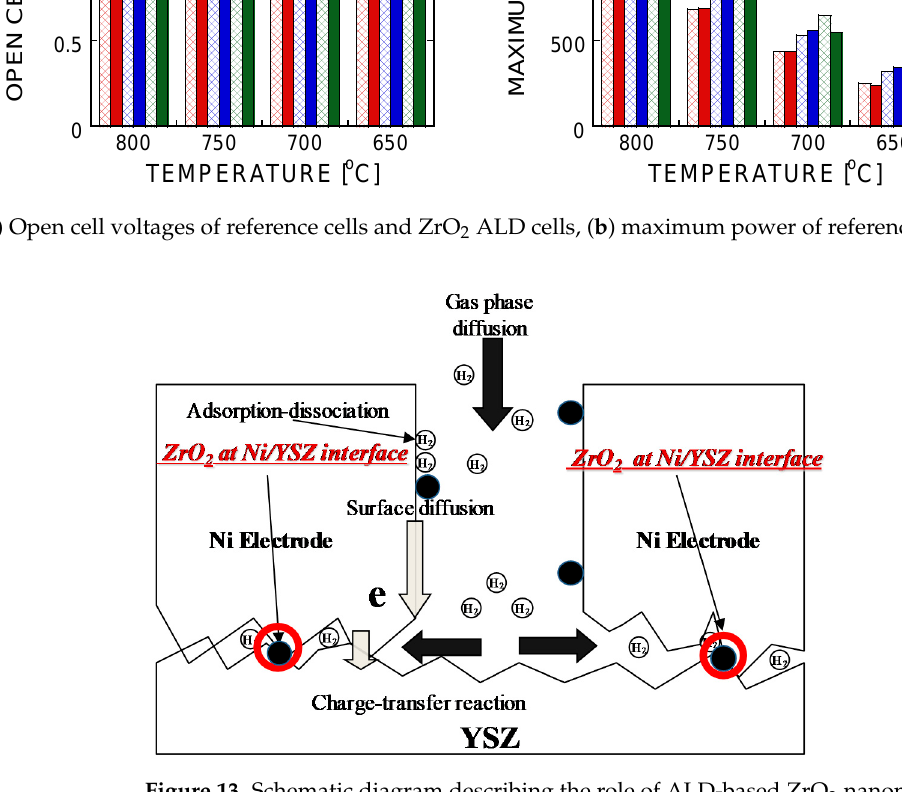
Figure 13. Schematic diagram describing the role of ALD-based ZrO 2 nanomaterials in the electro- chemical performances of SOFC anodes.